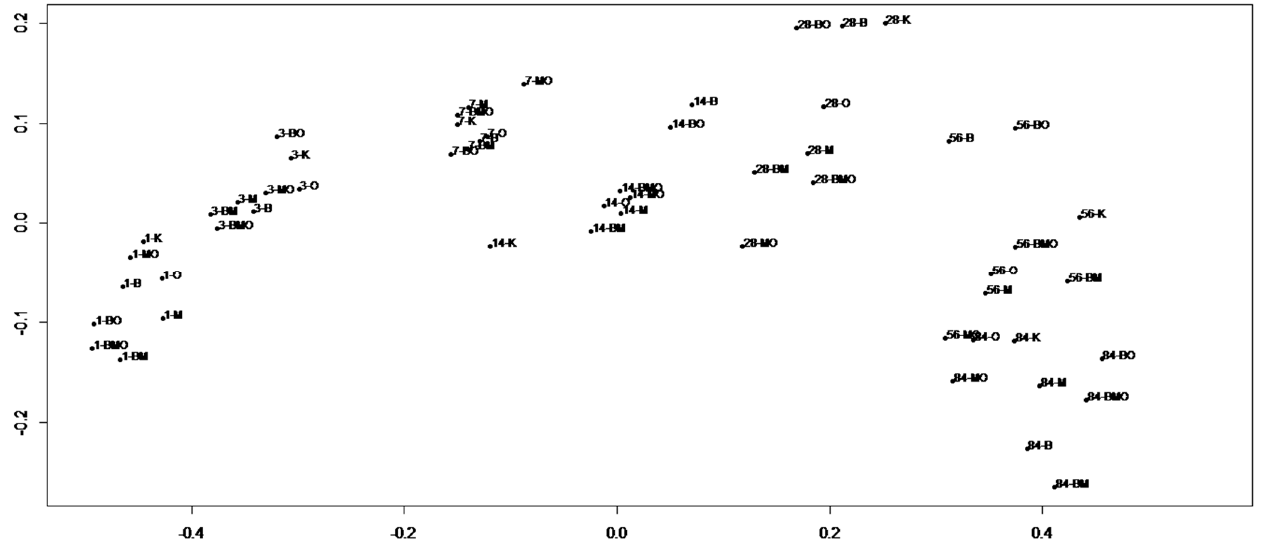
Figure 6. Beta-diversity of the bacterial communities of the compost mixtures (numbers represent the days of sampling and letters the names of the